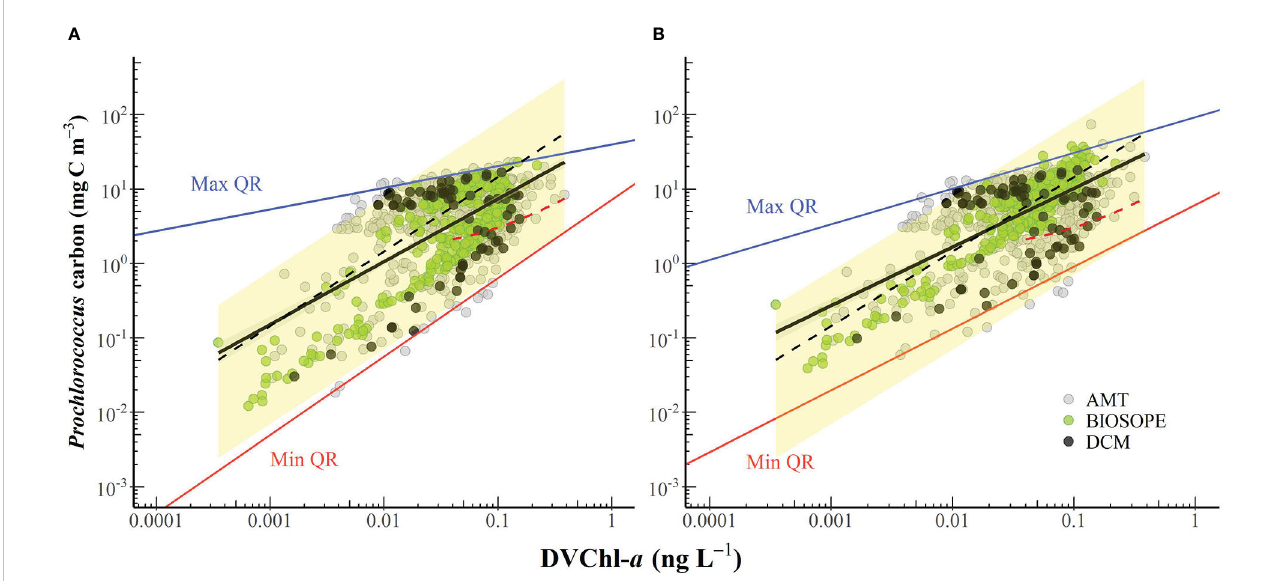
FIGURE 8 The cell carbon biomass of Prochlorococcus plotted against the concentration of divinyl chlorophyll- a (DVChl- a ). Carbon content was converted from cell abundances using the conversion factor of (A) 49 fg C cell -1 (Cailliau et al., 1996) and (B) 52 and 158 fg C cell -1 for euphotic and sub-euphotic populations, respectively (Casey et al., 2013). The black line represents the line of best fi t (panel A: log y = 0.843 log x + 1.711, R 2 = 0.41; panel B: log y = 0.788 log x + 1.798, R 2 = 0.47), and the grey shaded area indicates the 95% con fi dence interval. The upper (solid blue line) and lower (solid red line) boundaries correspond to the maximum (99th) and minimum (1st) quantiles, respectively. The black dashed line corresponds to the carbon-to-DVChl- a of Prochlorococcus ( q Pro ) of 145 g C (g DVChl- a ) -1 reported in Sathyendranath et al. (2009). The red dashed line represents the relationship observed by Latasa et al. (2022) in the northwestern Mediterranean Sea in September 2009 when the measured DVChl- a concentrations were always greater than 0.04 mg m -3 . The yellow- shaded area represents the possible range of q Pro values reported in the